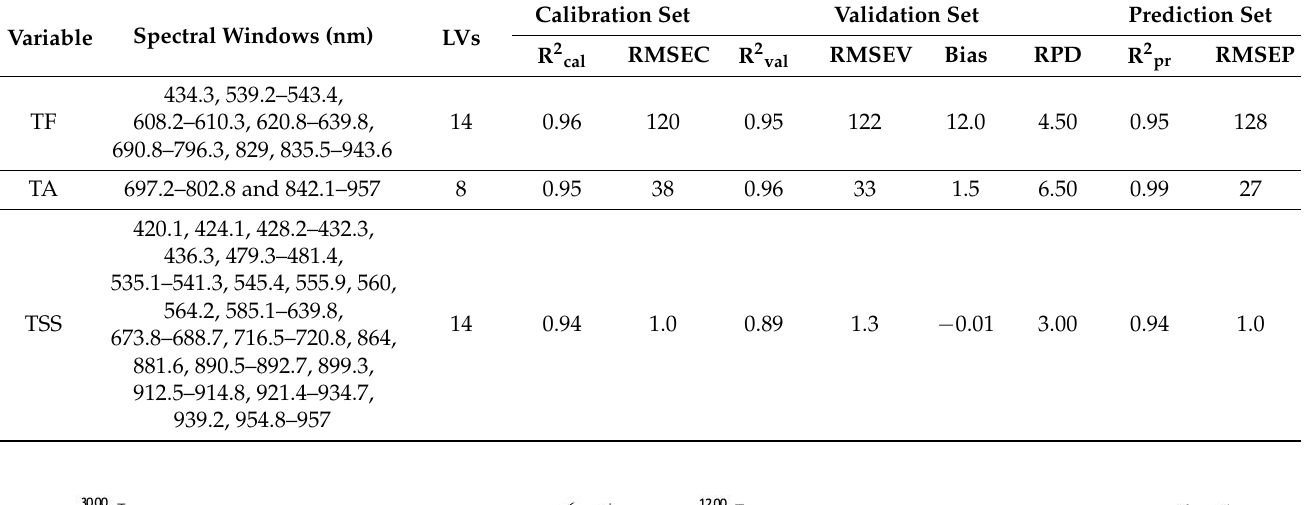
Table 5. Performance of Variable Importance in Projections (VIPs)-PLS models for predicting Total Flavonoids (TF), Total Anthocyanins (TA), and the Total Soluble Solids (TSS) using only the optimal wavelengths windows extracted from VIPs of PLS full spectra analysis.